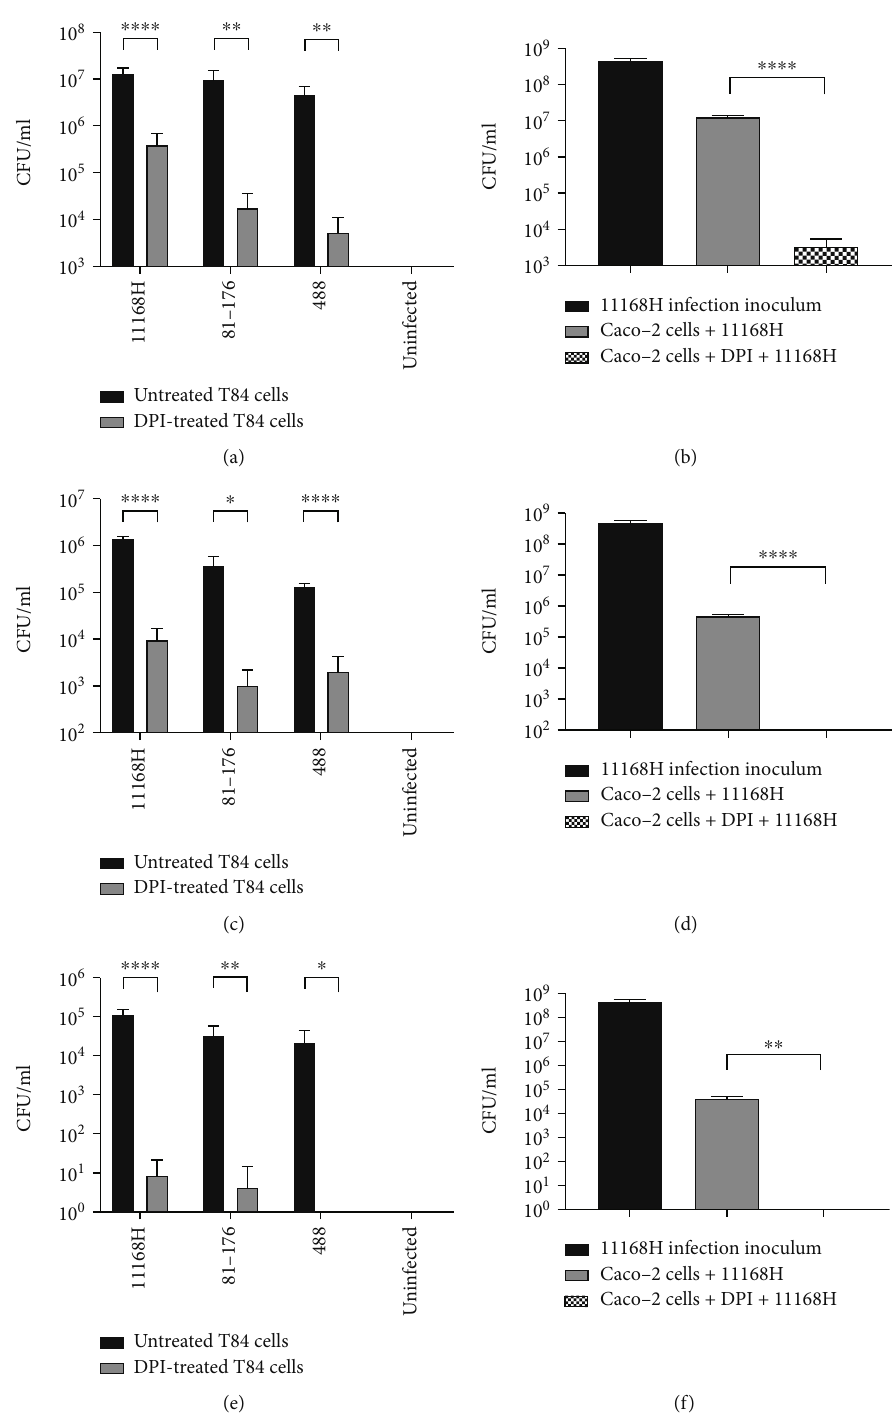
Figure 6: The e ff ect of DPI on C. jejuni interaction, invasion, and intracellular survival. T84 and Caco-2 cells were pretreated with 10 μ M of DPI for 1 hour and infected with C. jejuni for 3 hours. (a) T84 and (b) Caco-2 cells were washed with PBS and lysed, and the numbers of interacting bacteria were assessed. (c, d) For invasion assay, after infection with C. jejuni , IECs were incubated with gentamicin (150 μ g/ml) for 2 hours to kill extracellular bacteria and then lysed, and the numbers of intracellular bacteria were assessed. (e, f) For intracellular survival assay, 2 hours of gentamicin treatment was followed by further incubation with gentamicin (10 μ g/ml) for 18 hours. Then, cells were lysed, and the numbers of intracellular bacteria were assessed. Experiments were repeated in three biological and three technical replicates. Asterisks denote a statistically signi fi cant di ff erence ( ∗ p < 0 : 05 ; ∗∗ p < 0 : 01 ; ∗∗∗∗ p < 0 : 0001